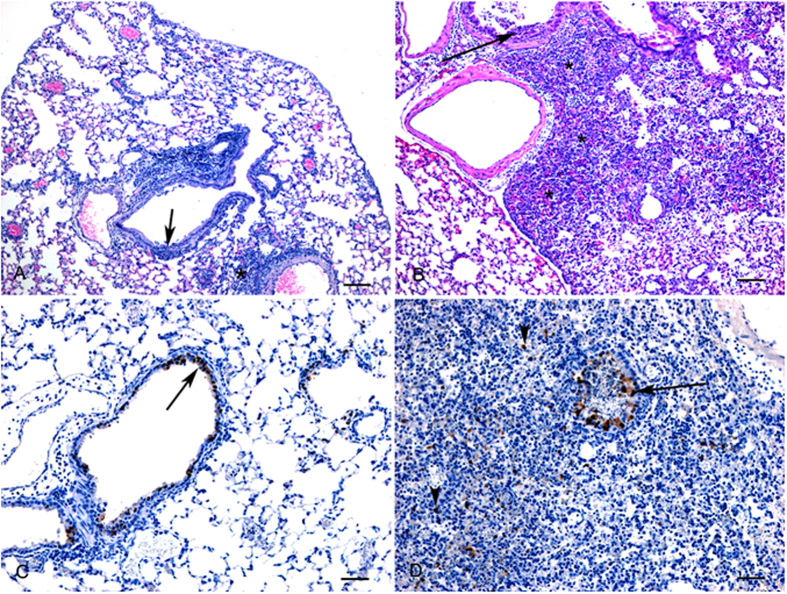
Histopathology (HE) and immunohistochemistry (IHC) findings in lungs from H5N1 infected mice.(A) Day 3: Mild to moderate bronchiolitis (arrow) and scattered foci of interstitial pneumonia (*). HE, bar = 100 μm. (B) Day 6: Large areas of necrotizing interstitial pneumonia (*) and bronchiolitis (arrow). HE, bar = 100 μm. (C) Day 3: Positive immunostaining for influenza A antigen is primarily observed in bronchiolar epithelial cells (arrow). IHC, bar = 50 μm. (D) Day 6: Viral antigen is detected in bronchiolar epithelial cells (arrows) as well as in macrophages (arrowheads). IHC, bar = 50 μm.